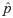
Comparison of the performance of the nutrient-only and precursor-only strategies after a nutrient upshift.A: Trajectory in the phase plane for the nutrient-only strategy (green curve). The solid, black curve represents the p^-nullcline. The dashed, black curve is the r^-nullcline. The solution is obtained by numerical simulation of the system of Eqs 11 and 12, supplemented with α = f(EM) as specified by Eq 27 in the Methods section and plotted in S1 Fig. The initial state corresponds to the steady state attained for an environment given by 0.2EM. While converging to the new steady state after the upshift, the precursor concentration makes a large overshoot. B: As above, but for the precursor-only strategy. The feedback control strategy is now defined by α=g(p^) as specified by Eq 28 in the Methods section and plotted in S1 Fig. The solution trajectory (blue curve) exhibits a lower overshoot. C: Evolution of the control variable α(⋅) as a function of time, for each of the above two strategies. Notice that in the nutrient-only strategy α(⋅) immediately jumps to the optimal value for the post-upshift steady state (green curve), whereas in the precursor-only strategy it depends on the (time-varying) precursor concentration (blue curve). D: Evolution of the ratio Vol/Volopt as a function of time, where Vol is the volume of the self-replicator and Volopt the volume of the same replicator following the optimal strategy shown in Fig 4. In all of the above simulations, the parameter values EM = 1 and K = 0.003 were used.